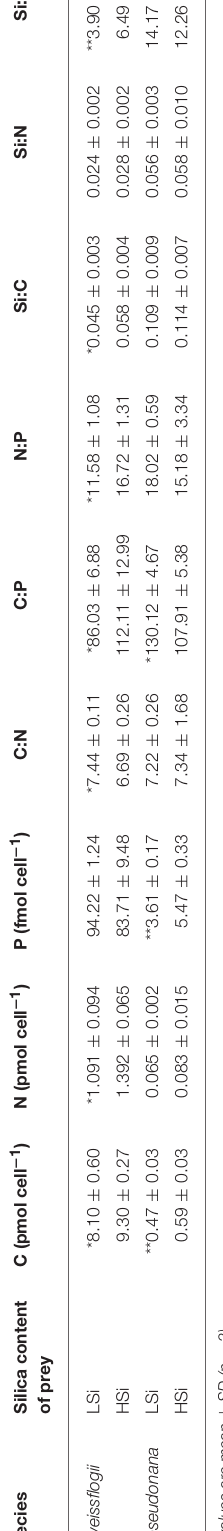
TABLE 1 | Cell size (ESD, µ m) and silica content (fmol cell − 1 ) of the diatom prey used in each experiment.